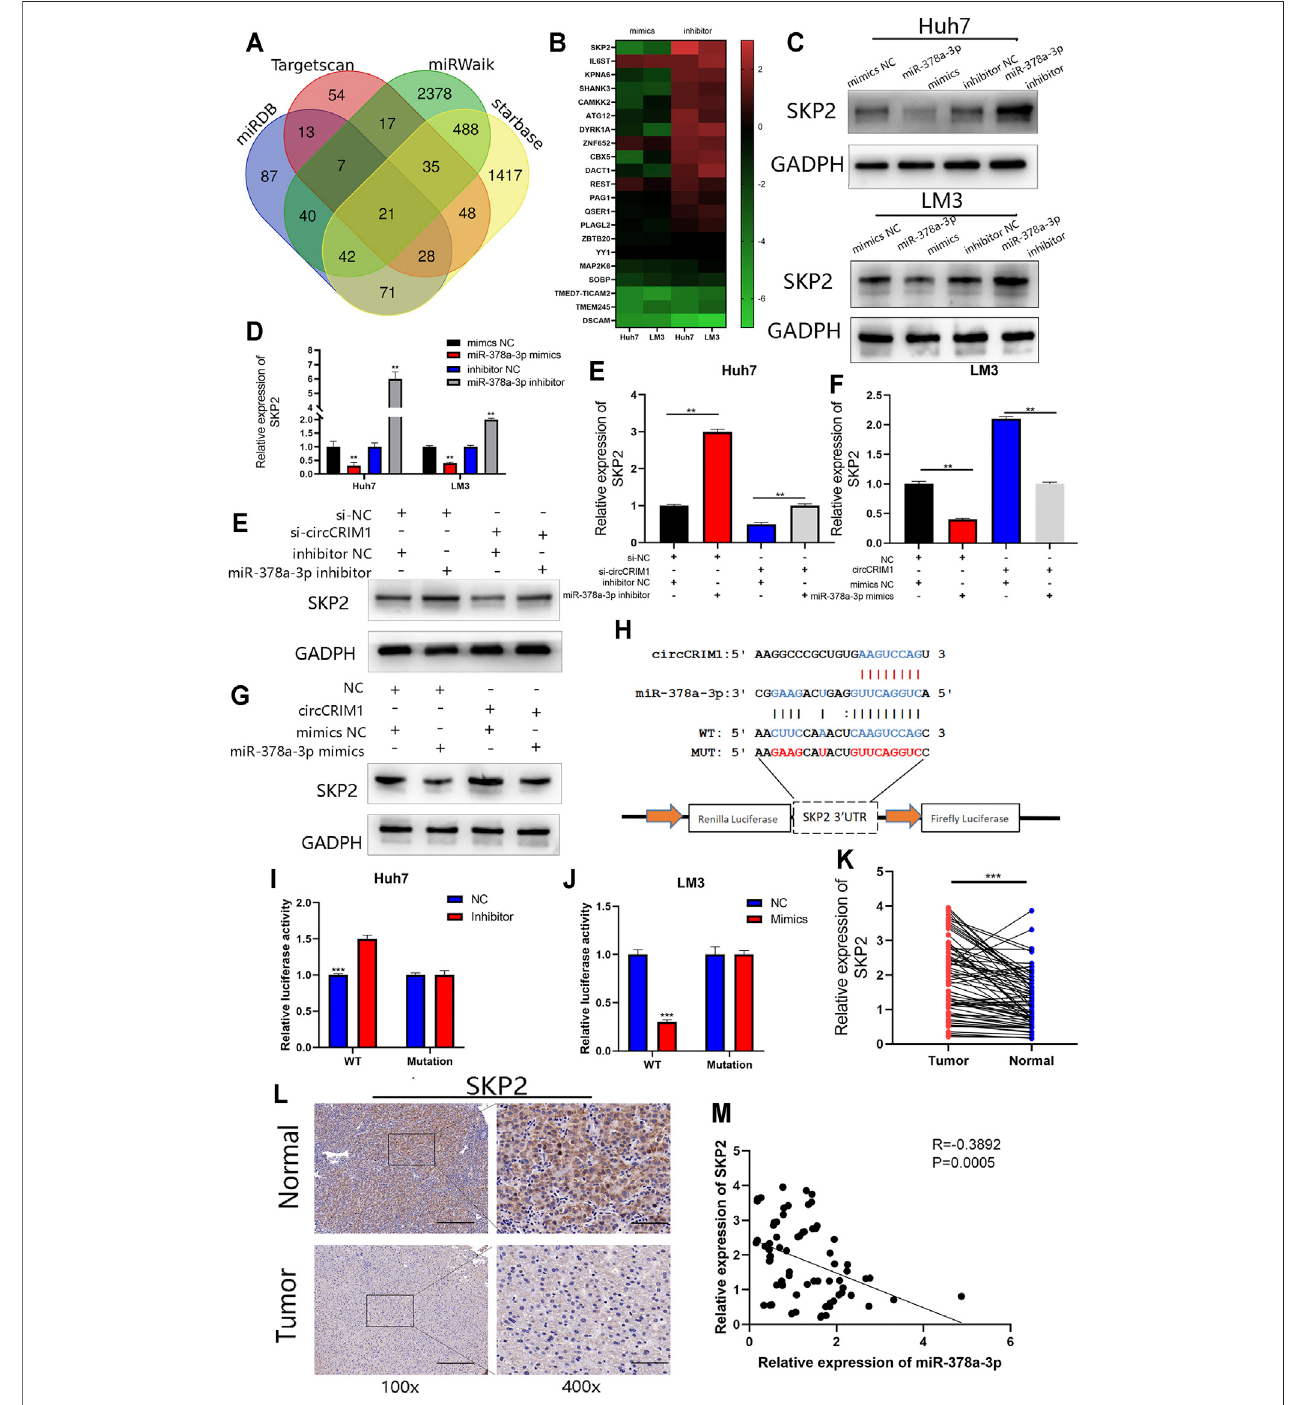
FIGURE 6 | SKP2 is a direct target of miR-378a-3p and is indirectly regulated by circCRIM1. (A) Venn diagram showing 21 genes that are putative miR-378a-3p targets predicted by four algorithms (TargetScan, miRDB, starbase, and miRWalk). (B) Heat map was used to visualize the expression of predicted target genes in LM3 and Huh7 cells transfected with miR-378a-3p mimics, inhibitor, and corresponding NC. (C,D) SKP2 expression in Huh7 and LM3 cells was analyzed by RT-qPCR and western blotting after transfection with miR-378a-3p mimics, inhibitor, and corresponding NC. (E – G) SKP2 expression was analyzed by RT-qPCR and western blotting. LM3 cells were transfected with miR-378a-3p mimic or co-transfected with corresponding indicated circCRIM1 vectors and Huh7. (H) Schematic of SKP2 3 ′ UTR WT and MUT luciferase reporter vectors. (I,J) Effects of miR-378a-3p mimics and inhibitor on luciferase activities of SKP2 3 ′ UTR WT and MUT. (K) RT-qPCR analysis of SKP2 expression in HCC tissues ( n (cid:2) 76) paired with adjacent normal tissues ( n (cid:2) 76). (L) IHC staining of SKP2 in HCC and adjacent normal tissues from patients. Samples were imaged at 100 × and 400 × magni fi cation. Scale bar, 100 and 25 μ m (M) Negative relationship between levels of miR-378a-3p and SKP2 was identi fi ed in 76 paired HCC and normal liver tissues by Pearson correlation analysis. All data are presented as the means ± SD of three independent experiments. * p < 0.05, ** p < 0.01, *** p < 0.001, and **** p < 0.0001. Frontiers in Cell and Developmental Biology |